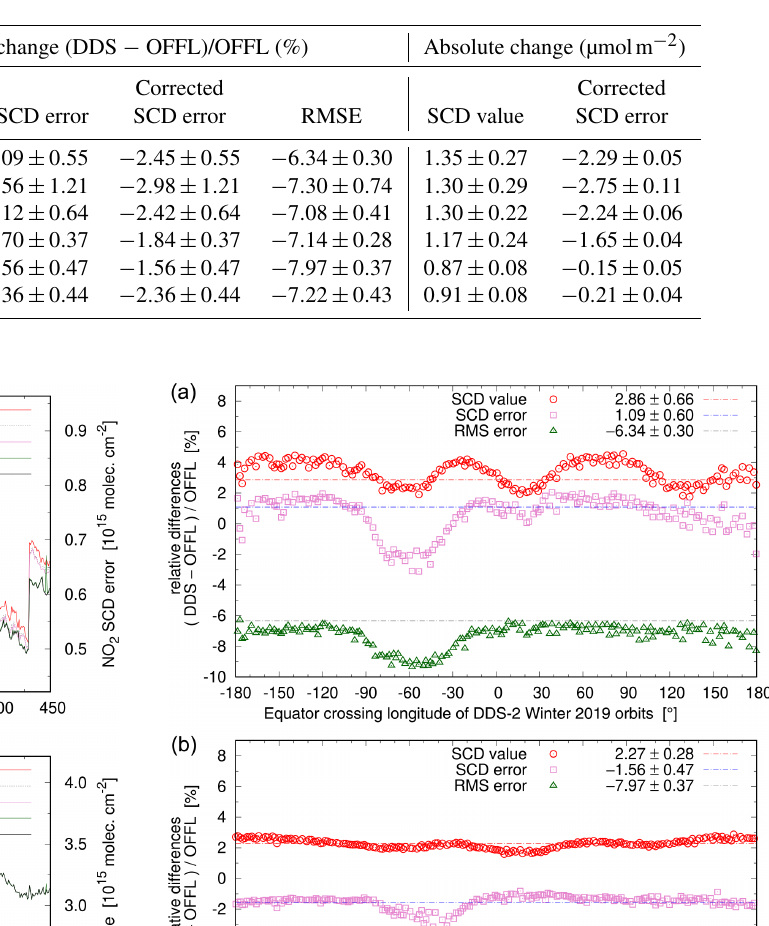
Table 3. Relative and absolute differences in some DOAS retrieval results between the DDS and OFFL data averaged over the full DDS-2 and DDS-3 periods (cf. Table 1) for the ground pixels with valid SCD retrieval results in the 30 ◦ tropical latitude region.